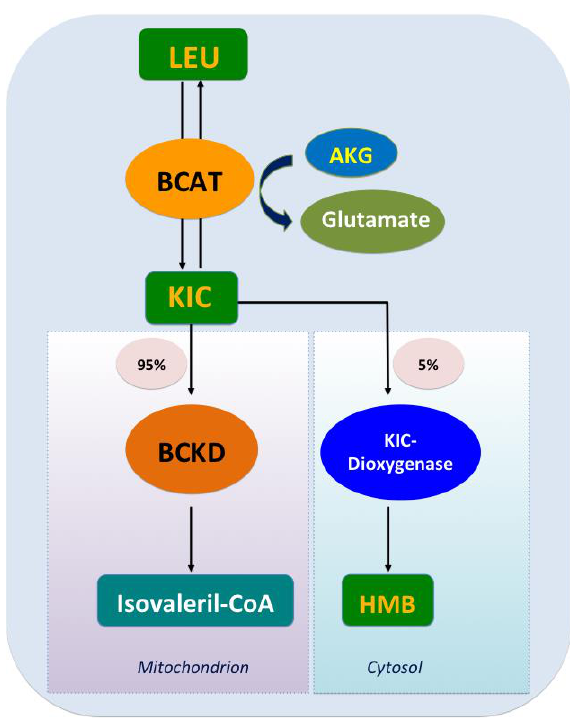
Figure 1. Leucine catabolism. After leucine ingestion, the reversible transamination of leucine to α -ketoisocaproate (KIC) occurs, through branched-chain amino acid (BCAA) transferase (BCAT) present in various tissues, and then approximately 5% of KIC is converted into β -hydroxy- β -methylbutyrate (HMB) by the cytosolic enzyme KIC dioxygenase, and about 95% ingested KIC is metabolized into isovaleryl-CoA, which is catalyzed predominantly by the mitochondrial branched chain a-keto acid dehydrogenase (BCKD).